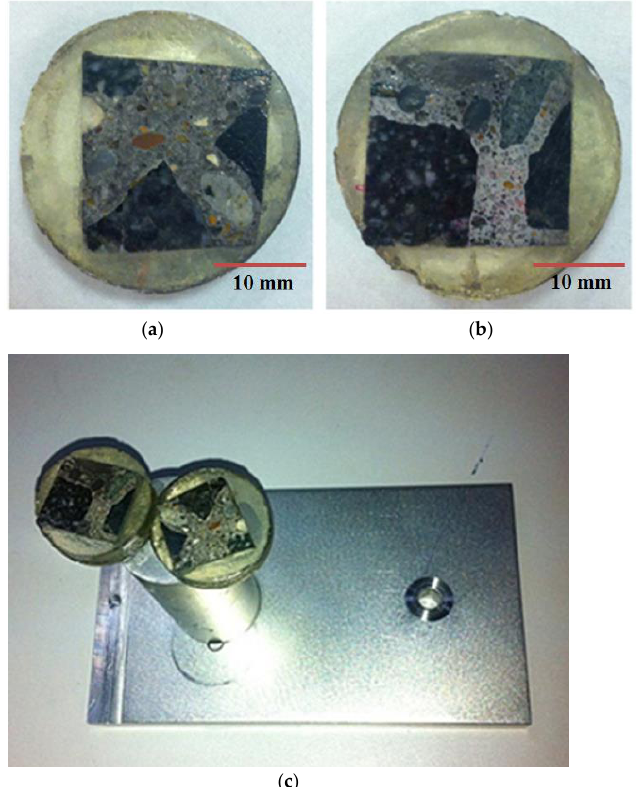
Figure 1. Samples for testing in nanoindenter [15,16]: ( a ) specimen 1; ( b ) specimen 2; and ( c ) specimens installed.